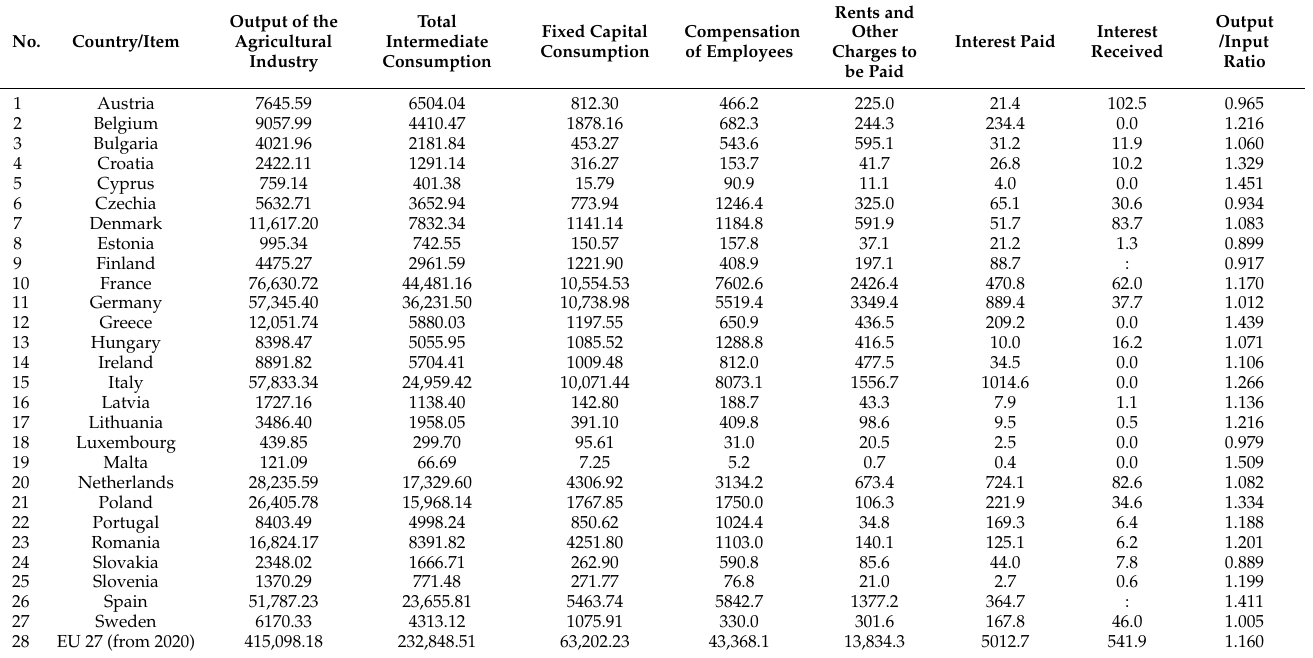
Table 11. Output/input ratio calculation based on economic results and consumptions (million euro).